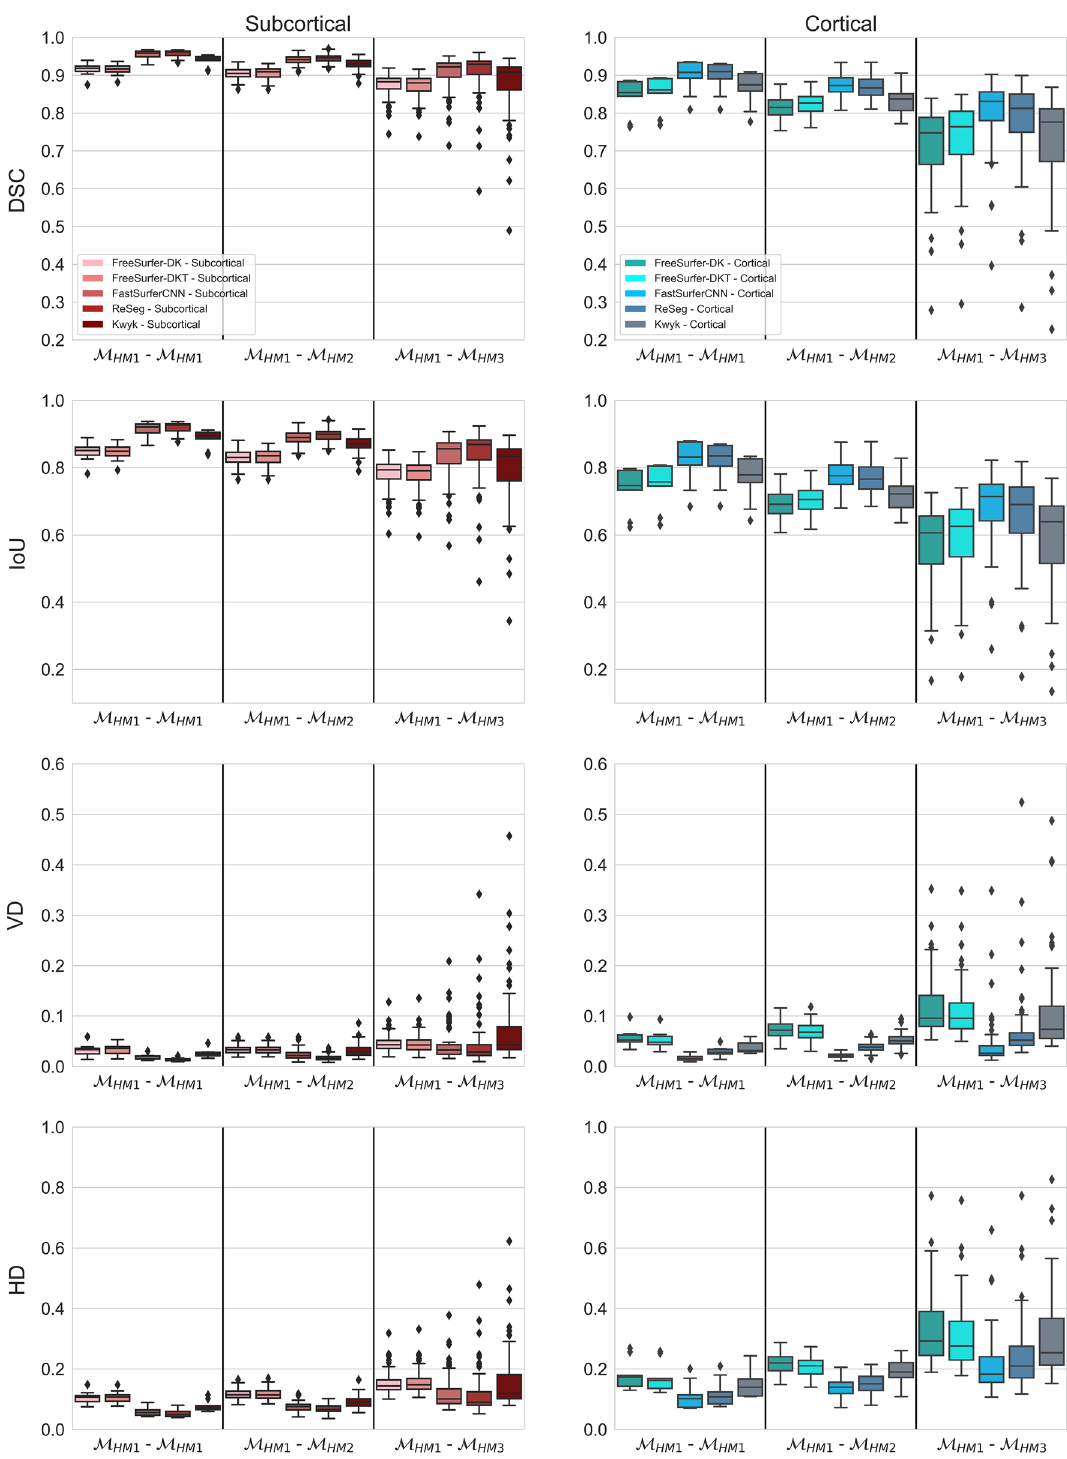
Figure 3. Boxplots showing the distributions of the dice similarity coefficient (DSC), intersection over union (IoU), volumetric difference (DF), and Hausdorff distance (HD) for FreeSurfer and deep learning-based segmentation methods. Evaluation metrics were calculated to compare the segmentation masks generated for good quality images acquired under rest to the masks generated for good ( M HM 1 — M HM 1 ), medium ( M HM 1 — M HM 2 ), and bad quality images ( M HM 1 — M HM 3 ) acquired under active head